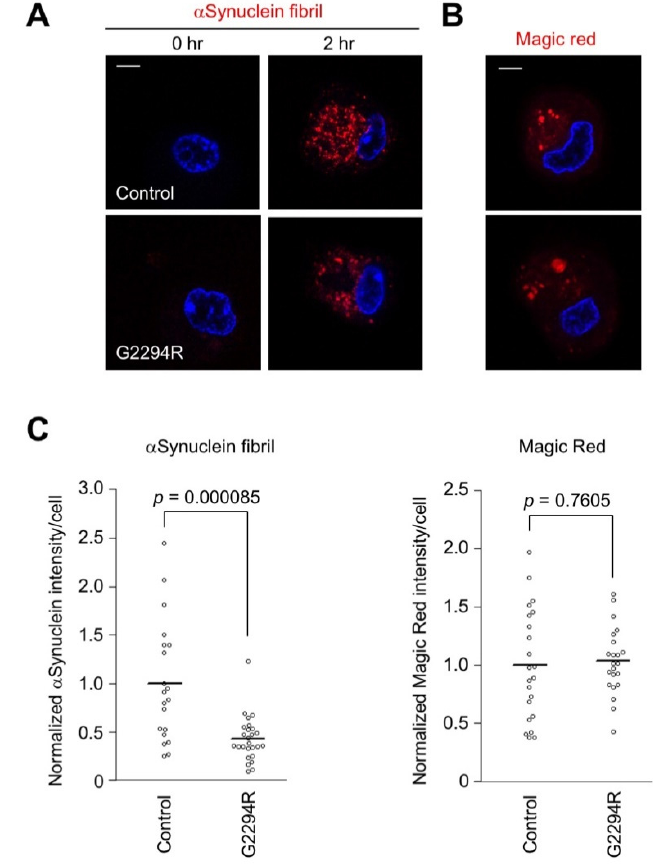
Figure 4. Uptake of α -synuclein fibrils is impaired by p.G2294R variant. ( A ) Macrophages differentiated from monocytes were treated with α -synuclein fibrils conjugated with AcidiFluor ORANGE for 2 h. The fluorescence of α -synuclein fibrils activated in low-pH endolysosomal vesicles (red) and nuclei (blue) was imaged. The scale bar is 5 µm. ( B ) The cathepsin B activity (red) in the macrophages was imaged using Magic Red substrate. The scale bar is 5 µm. ( C ) The quantification of phagocytosed α -synuclein fibrils and cathepsin B activity. The bars in the graphs represent the mean ( n ≥ 20); Student’s t -test.